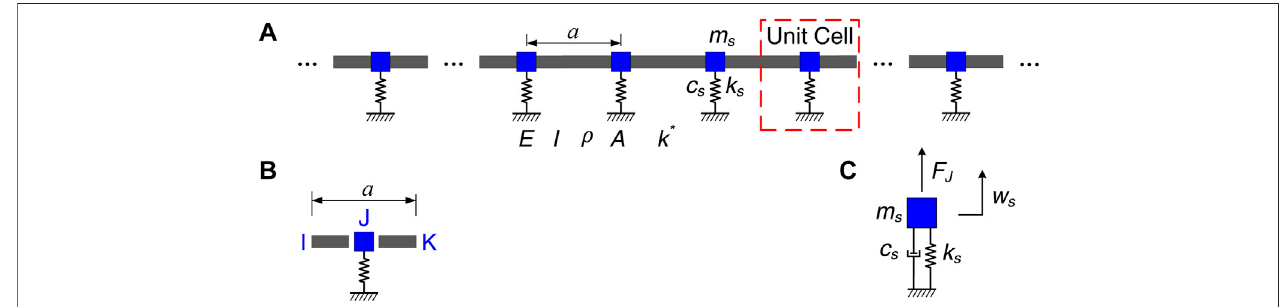
FIGURE1| Thephysicsmodel: (A) Schematicdiagramofin fi nitelonghomogeneousbeamcoupledwithperiodicoscillators; (B) Schematicdiagramoftheunitcell; (C) The beam-oscillators coupling system in a unit cell.